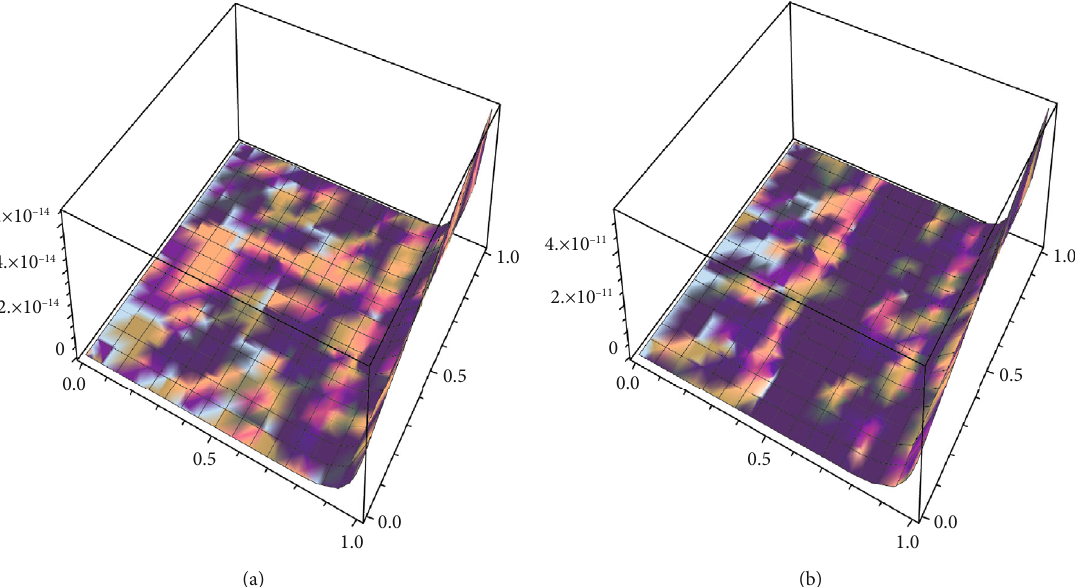
Figure 6: The FRDTM solutions u ð x , y , z Þ : (a) α = 1 : 8 and (b) α = 1 : 4